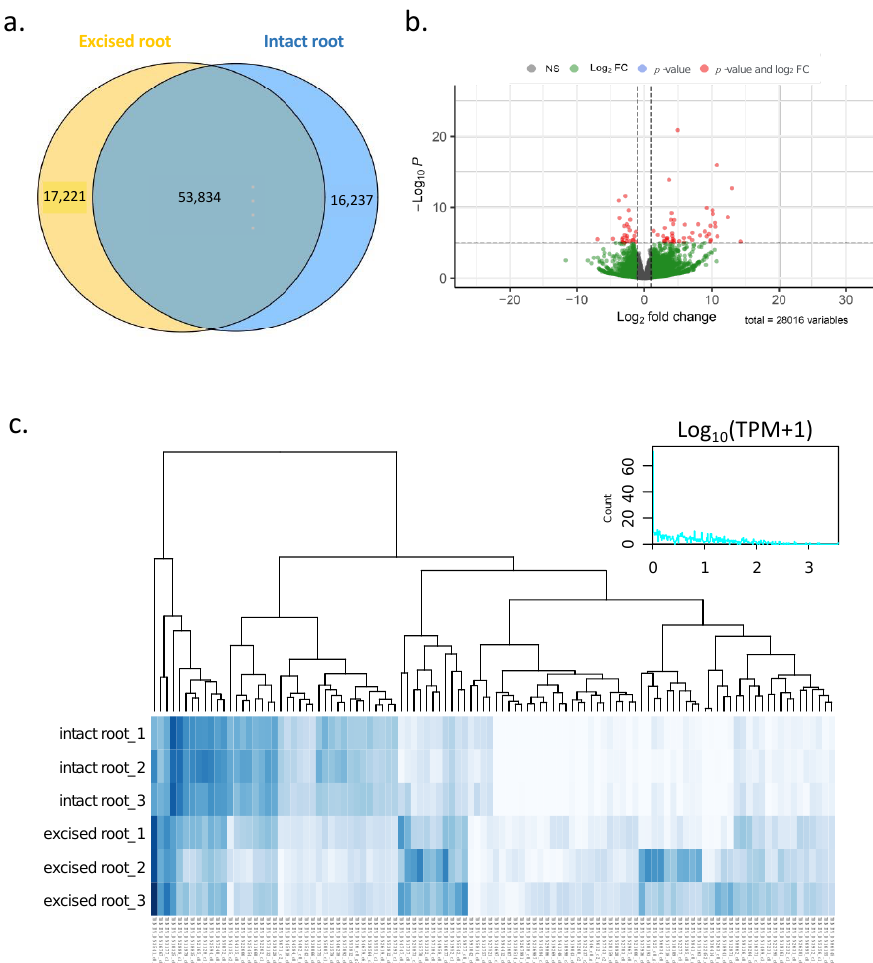
Figure 3. Gene expression in intact and excised roots. ( a ) Venn diagram of genes that were significant differentially expressed in intact and excised root samples. ( b ) Distribution and expression levels of differentially expressed genes (DEGs) of excised and intact roots; the x -axis represents the log 2 (fold change) values under the mean normalized expression of all isoforms ( y -axis). ( c ) Expression profiles retrieved from RNA-seq; the cluster displays expression patterns for a subset of genes with high log 2 (fold change) values in comparisons between intact and excised root sampled with three replications.